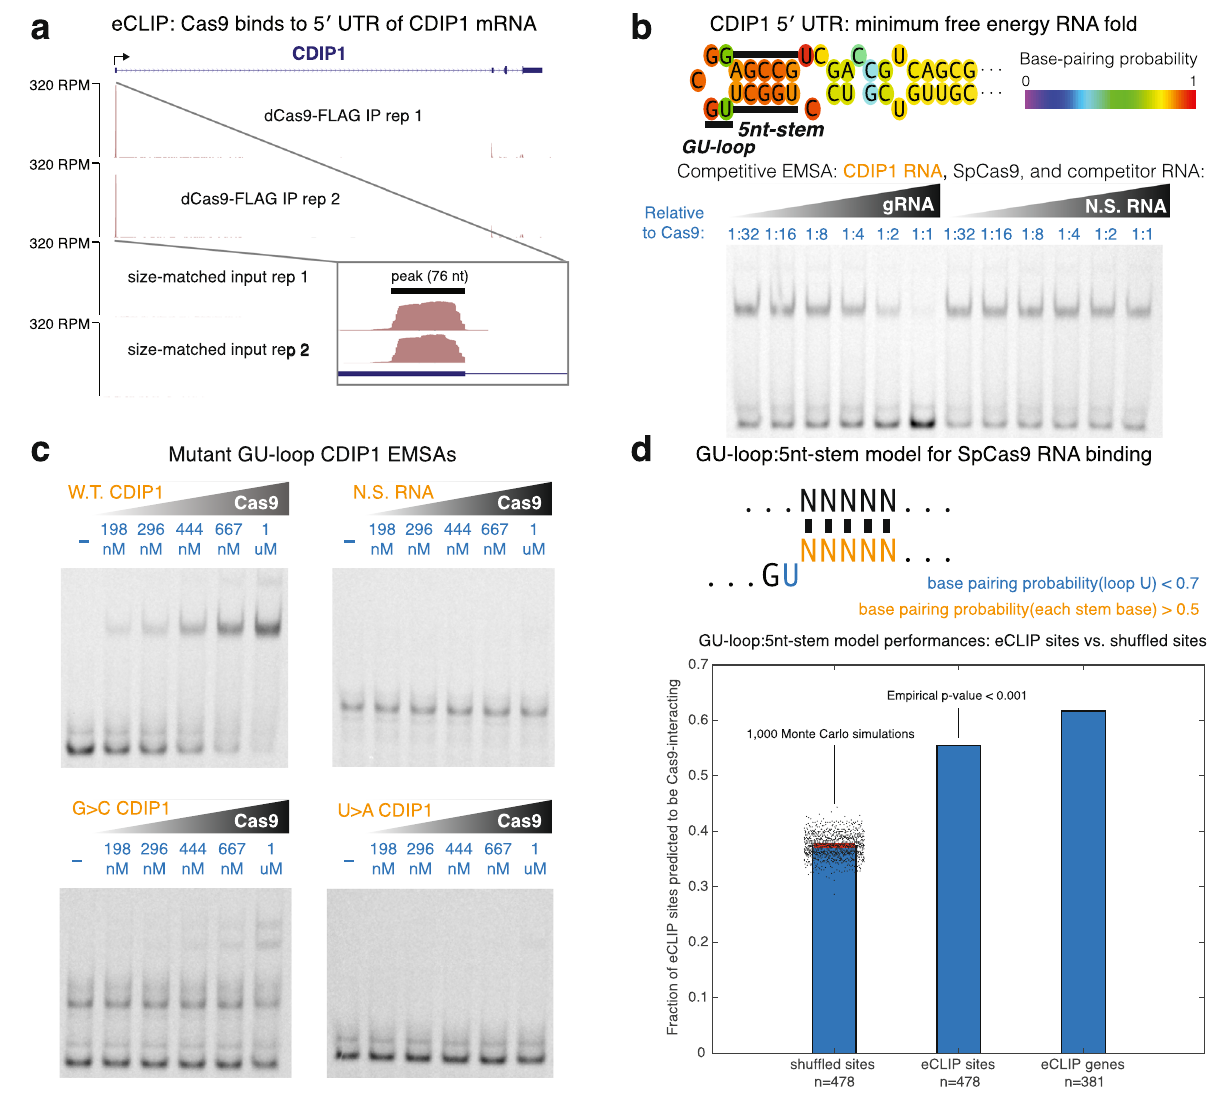
Fig. 2 The CRISPR RNA recognition domain of Cas9 binds to human RNA. a dSpCas9 binds to the 5 ′ UTR of CDIP1 mRNA. b A minimum free-energy RNA fold (Vienna RNAfold) of the CDIP1 5 ′ UTR reveals a GU-loop:5nt-stem sequence-structure motif, identical to the SpCas9 gRNA. gRNA outcompetes 20 nM of 5 ′ - fl uorescently labeled CDIP1 RNA, whereas non-speci fi c (N.S.) RNA does not, in a competitive EMSA (electrophoretic mobility shift assay). Experiments were performed independently in triplicate with similar results, with a representative gel shown. c SpCas9 protein binds to 20 nM of 5 ′ - fl uorescently labeled CDIP1 mRNA with an apparent dissociation constant ( K D ) in the high nanomolar range. Mutations to either the G or U of the GU-loop signi fi cantly reduce this binding af fi nity. Experiments were performed independently in triplicate with similar results, with a representative gel shown. d A GU-loop:5nt-stem model that searches an RNA sequence for a GU-loop motif (with the base-pairing probability of the U < 0.7) upstream of a 5nt-stem ( fi ve bases each with base-pairing probability > 0.5) trends with eCLIP peaks and genes predicted to interact with dSpCas9. The prediction of 1000 Monte Carlo simulations based on shuf fl ed eCLIP peak sequences is represented by scatter, where the mean is bold horizontal red line, and 95% con fi dence interval is lighter red box. Empirical p -value < 0.001 (Monte Carlo simulation). (Invisible plotted con fi dence interval is within plotted (| R 2 | values < 0.04 across all replicates) (Fig. 3b). If nickase Cas9- APOBEC fusion co-expressed with gRNA binds to and edits human RNA transcripts with which it also interacts in the absence of gRNA, we would expect RNA edit sites to cluster around eCLIP peak sites. In support of this, the mean fractions of C-to-U edits within sequence windows of 50, 100, 200, and 500 nt proximal to eCLIP peaks across replicates are signi fi cantly higher, relative to Monte Carlo simulated peaks across the represented transcripts (empirical p -value < 0.003 for W = 50; <0.0001 for W = 100, 200, 500) (Fig. 3c). This observation comports with our fi nding that APOBEC fusions to some RBPs can edit distances farther in linear space due to the dynamic and compact nature of mRNA conformations 26 . In the present study, differential RNA-